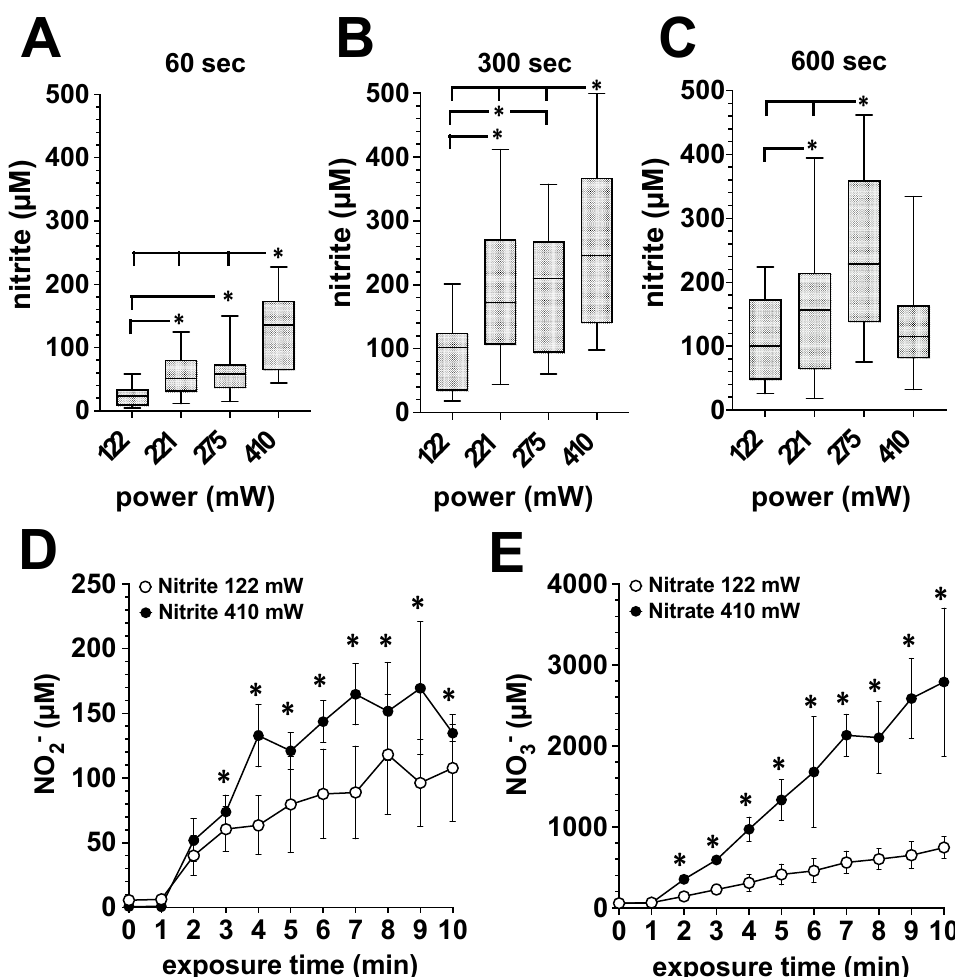
Figure 2. Influence of the power dissipation in the discharge on the plasma-induced accumulation of nitrite and nitrate in exposed bone tissue. Using the DBD plasma source, bone tissue samples were treated with plasma generated with the power dissipated in the discharge of 122, 221, 275 or 410 mW for for 1, 5 or 10 min. The nitrite and nitrate accumulation in the bone tissue was quantified by CLD, as described in the Material and Methods section. A ‐ C, Porcine bone tissue treated 60 s ( A ), 300 s ( B ) or 600 s ( C ) with plasma generated with the power dissipated in the discharge of 122, 221, 275 or 410 mW. Values of 9 individual ( n = 9) experiments are shown as boxplot with median value and with whiskers with minimum and maximum. *, p < 0.05. ( D ), Accumulation of nitrite or nitrate ( E ) in human bone tissue from the femoral head shaft after exposure to plasma generated with the power dissipated in the discharge of 122 mW (white circles) or 410 mW (black circles). Values represent the mean ± S.D. of four individual experiments. *, p < 0.05 as compared to the corresponding values obtained with the power dissipated in the discharge of 122 mW (white circles).